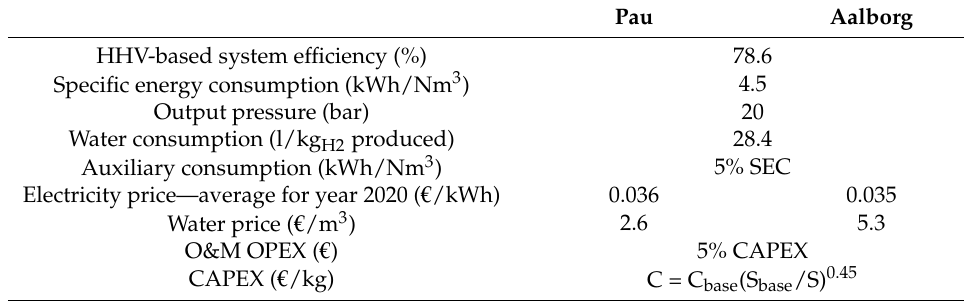
Table 4. Data used for the evaluation of the production